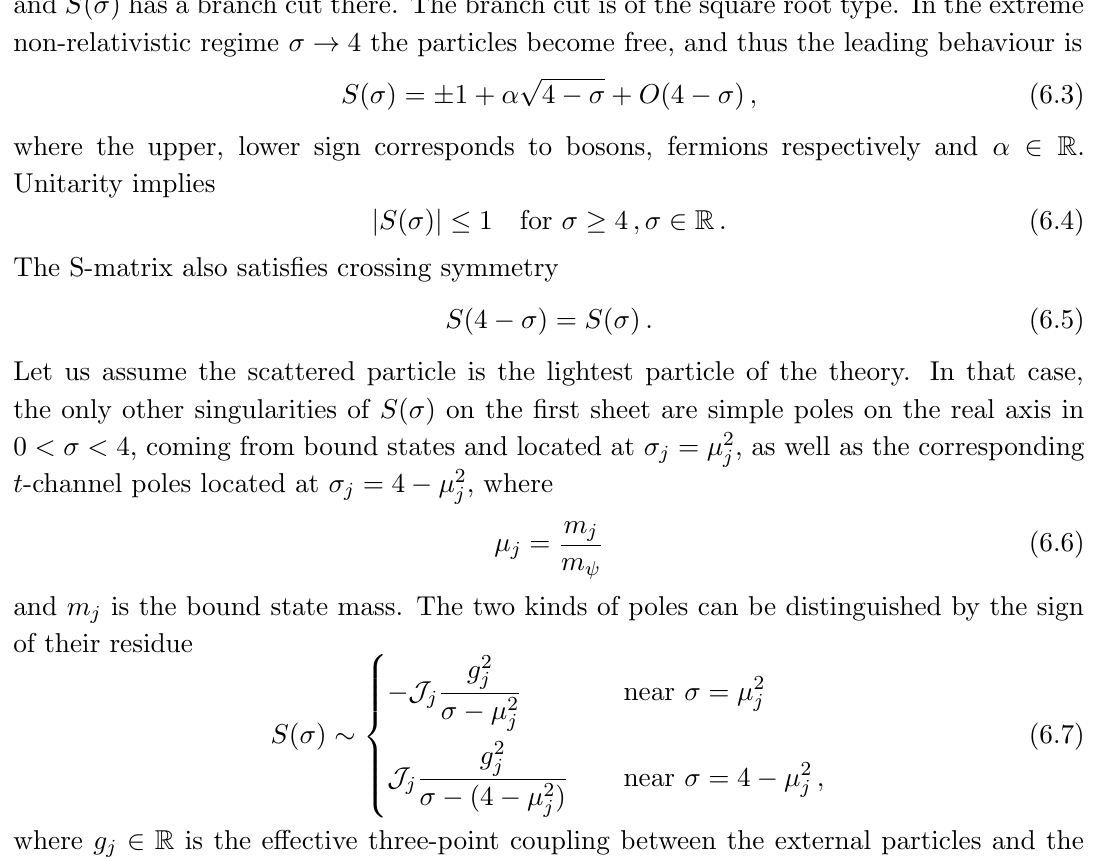
Figure 10 . The analytic structure of the S-matrix on the (cid:12)rst sheet. There is a branch cut for real (cid:27) > 4 corresponding to two-particle (cid:12)nal states. Crossing symmetry implies S (4 The region 0 < (cid:27) < 4 contains poles coming from bound states. Full and empty dots denote s- and t-channel poles